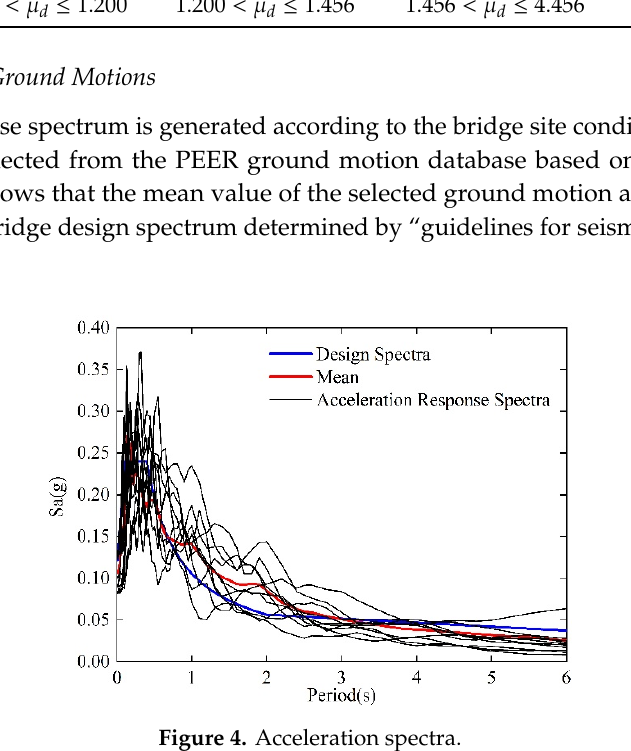
Table 2. Damage index of piers.